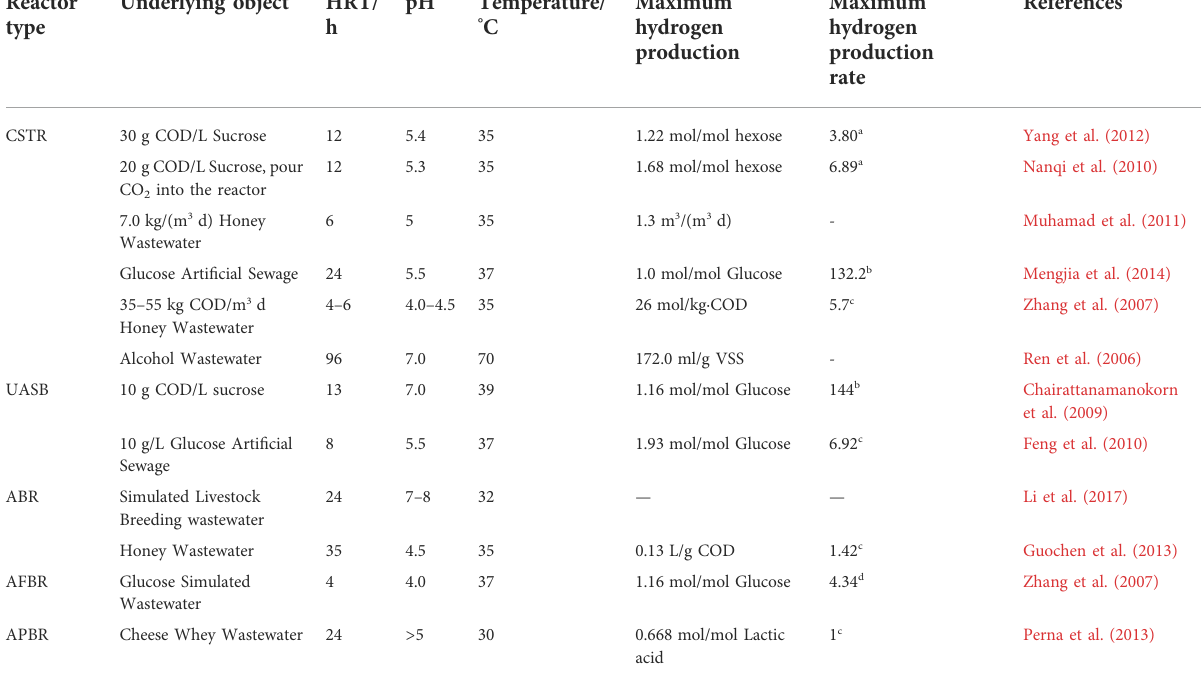
TABLE 3 Operating parameters and hydrogen production performance of the fermentative biological hydrogen production